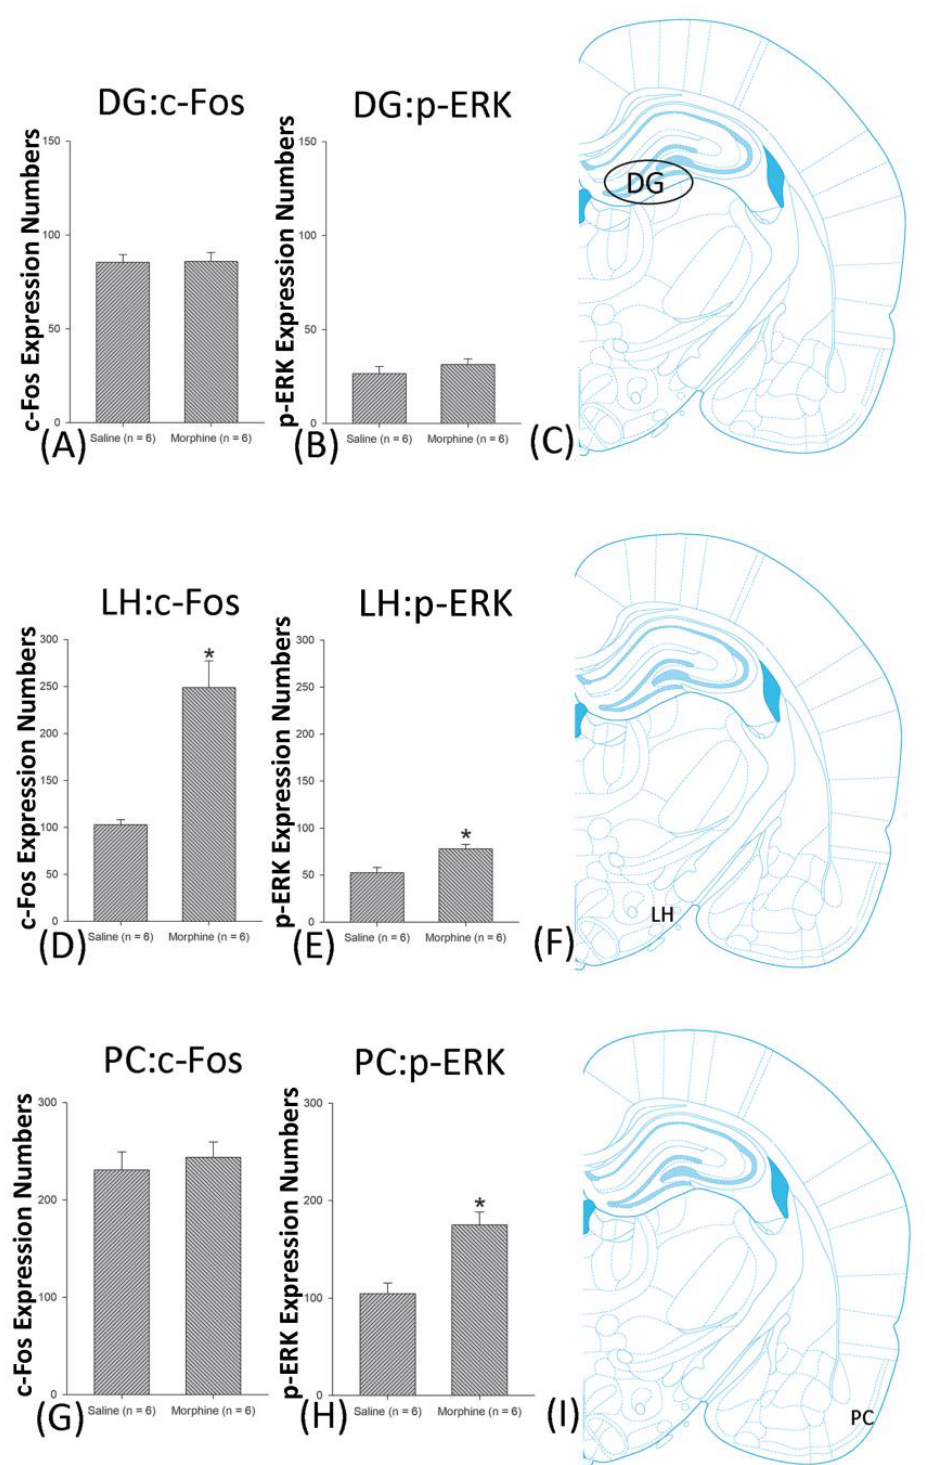
Figure 13. c-Fos or p-ERK expression in the dentate gyrus (DG), the lateral hypothalamus (LH), and the piriform cortex (PC) in extinction. ( A ) c-Fos and ( B ) p-ERK expression in the DG, ( D ) c-Fos and ( E ) p-ERK expression in the LH, and ( G ) c-Fos and ( H ). p-ERK expression in the PC for extinction. ( C , F , I ) indicate a schematic representation of the DG, LH, and PC. * p < 0.05 when comparing the saline and morphine groups ( n = 6 per group).